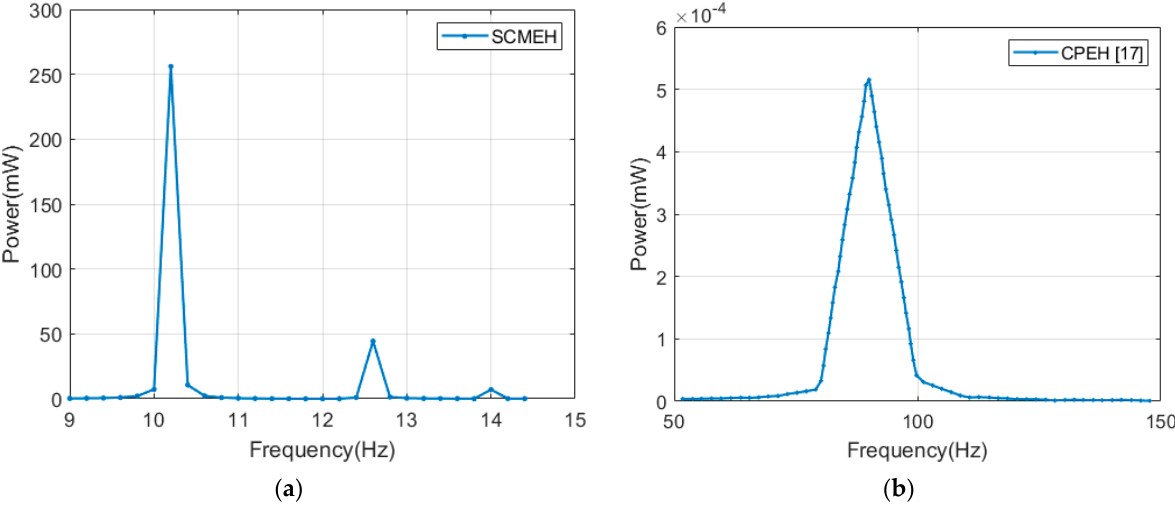
Figure 9. Power versus frequency ( a ) SCMEH and ( b ) CPEH [17].